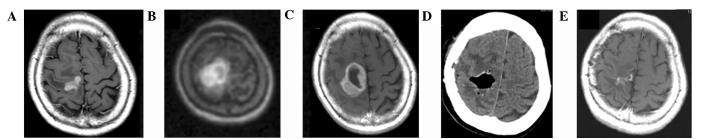
Imaging studies of the brain tumor at various stages of treatment. (A) Gadolinium-enhanced MRI captured during the patient’s initial visit showed evidence of an enhanced lesion near the right central sulcus and (B) 11C-methionine positron emission tomography revealed a lesion hot spot. (C) Gadolinium-enhanced MRI showed marked growth of the lesion in less than one month. (D) Computed tomography image of the cavity following tumor removal. (E) Gadolinium-enhanced MRI showed no recurrence approximately two years following surgery. MRI, magnetic resonance imaging.